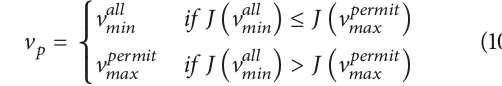
its first green phase. The new platoon consists of those vehicles behind SP that need to decelerate to V 󸀠 𝑝 to avoid idling at red light. The velocity space for the replanning velocity V 󸀠 𝑝 is similar to the passing velocity V 𝑝 except 𝑗 = 2, 3, ⋅ ⋅ ⋅ ∞